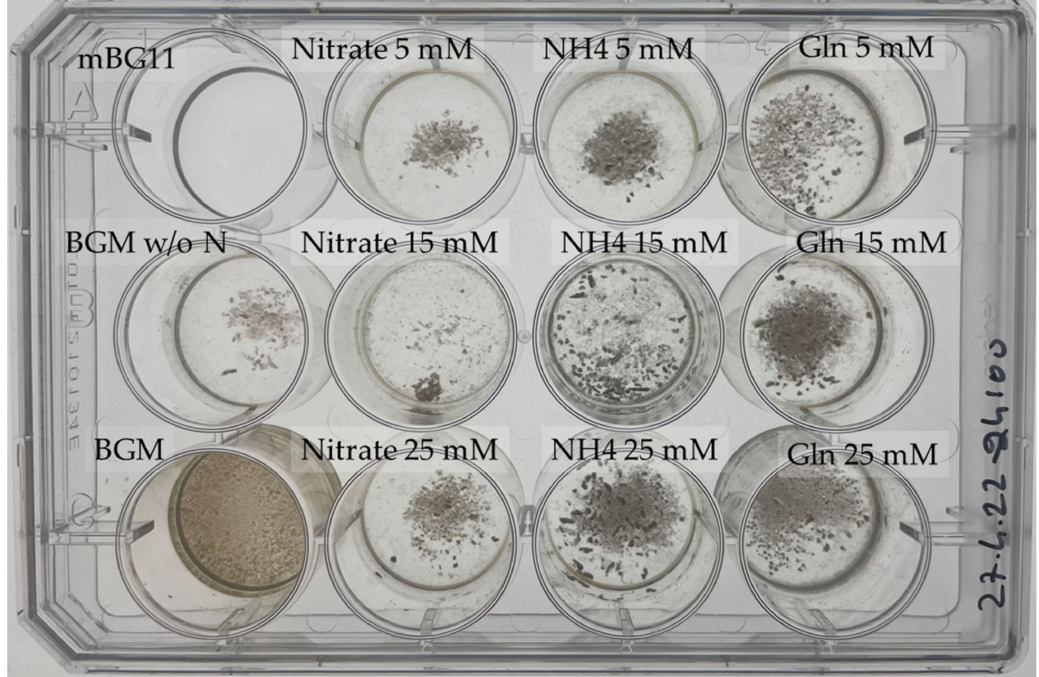
Figure 6. P. sedebokerense growth in culture media supplemented with nitrate, ammonia, and glu- tamine at 5, 15, and 25 milli equivalents of N. propagules (2 × 10 5 cells), respectively, and inoculated in 2 mL of BGM w/o nitrogen. The left column: BGM is the positive control and BGM w/o N and mBG are the negative controls; nitrate, ammonia, and glutamine (left to right, from second to fourth column) were added at 5, 15, and 25 milli equivalents of N (top to bottom), respectively, and cultures were grown for 10